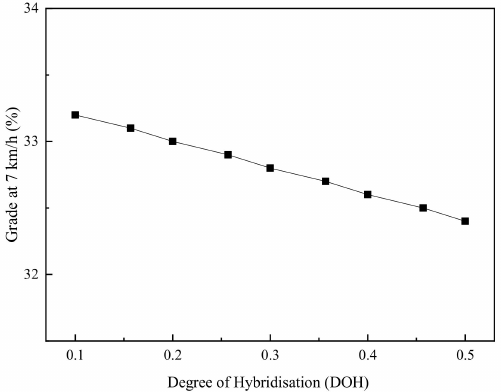
Figure 13. Curves of maximum grade at 7 km · h − 1 with DOH.